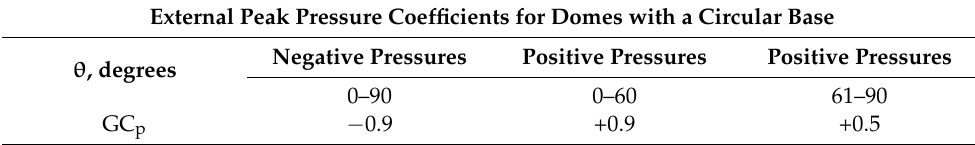
Table 3. External peak pressure coefficients for cladding design prescribed ASCE7-16 [21].